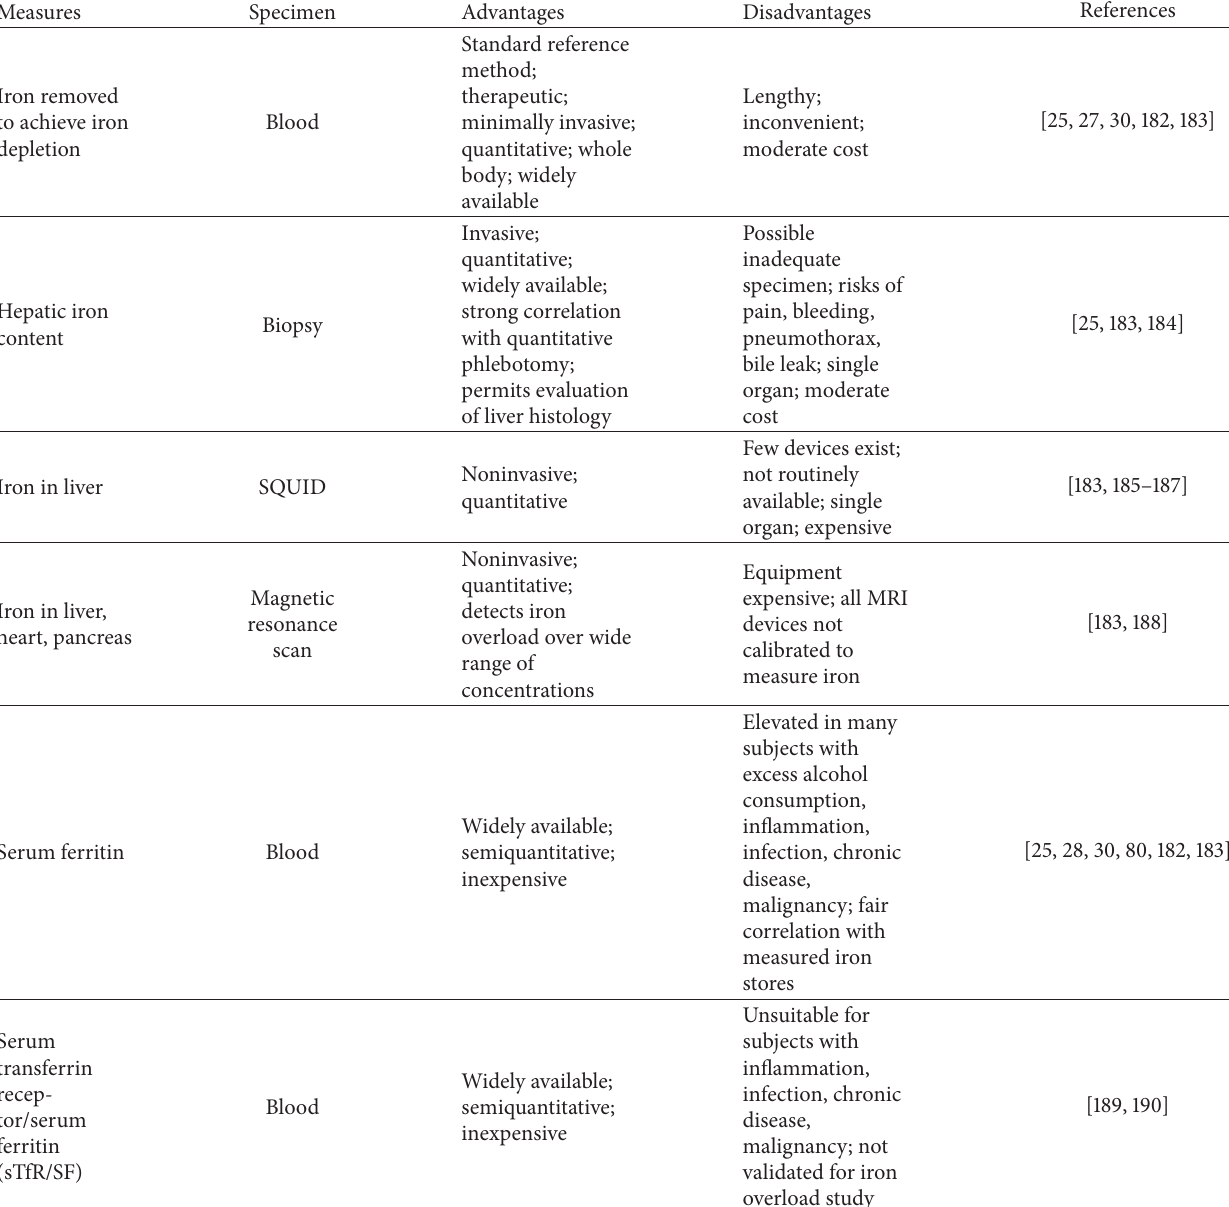
Table 1: Measures of body iron